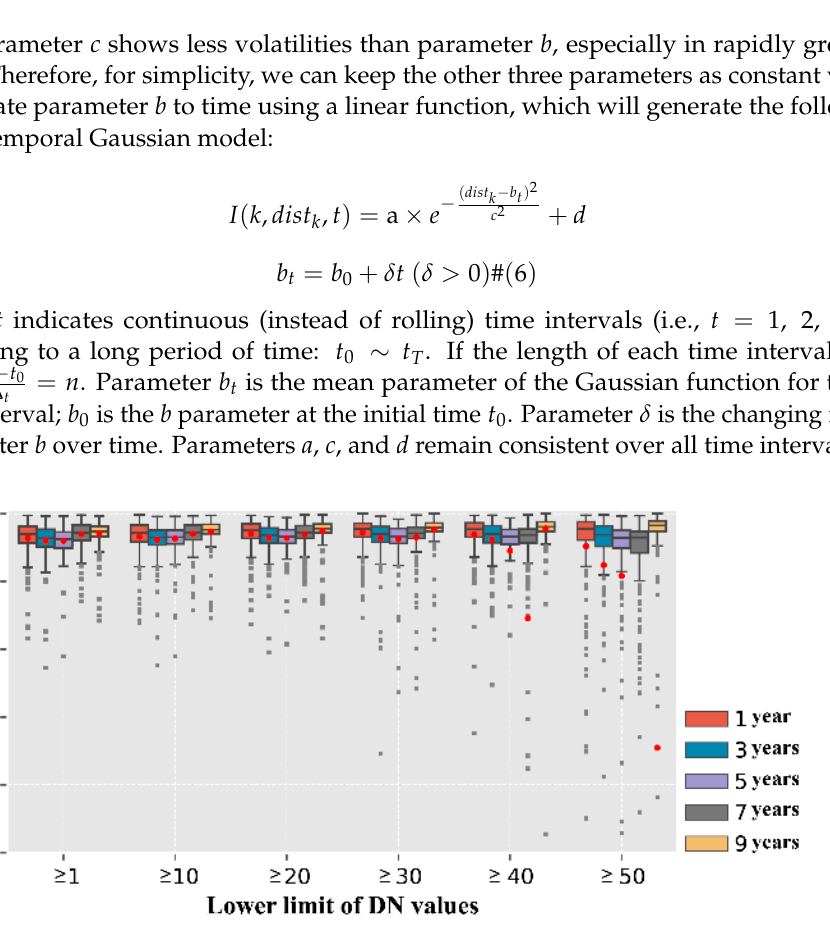
Figure 11. Degree of consistency ( R 2 ) between the observed and deduced patterns of total intensity of human activities of different levels, with the time intervals ranging from 1 to 9 years.